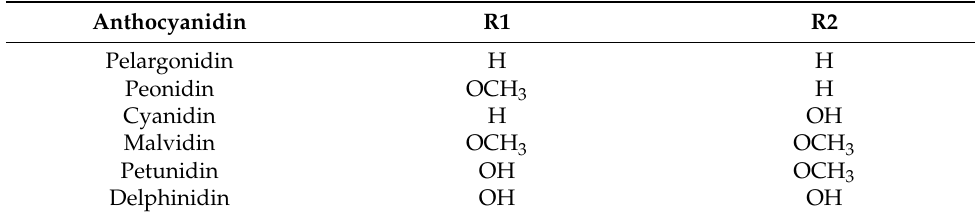
Figure 1. The structure of anthocyanins [18]. Table 1. Six most common anthocyanidins [18]. Table 1. Six most common anthocyanidins